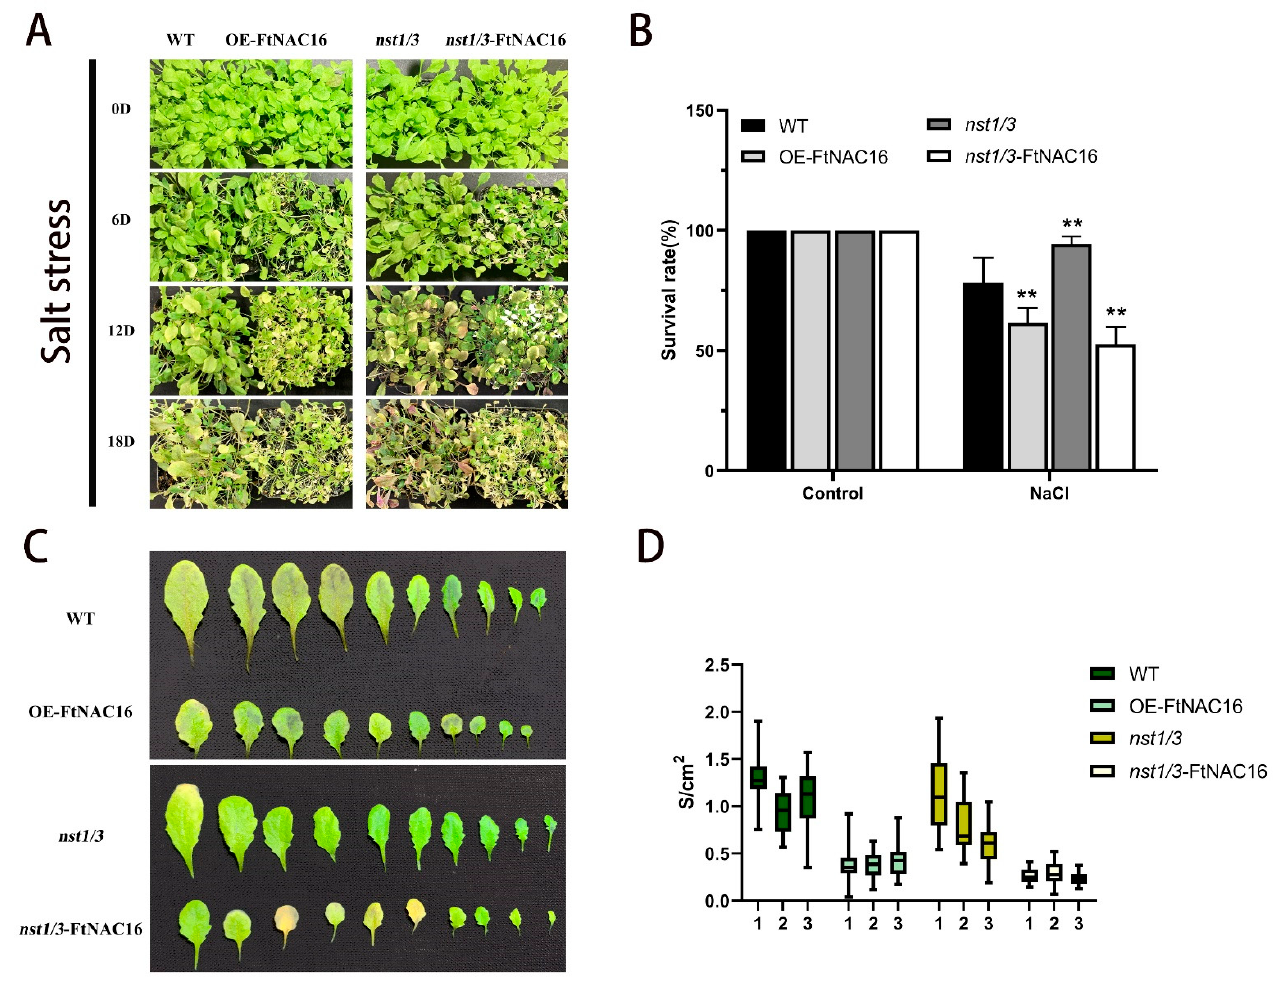
Figure 5. Phenotypic status of the four genotypes after salt stress treatment. ( A ) Growth status of A. thaliana at 0, 6, 12 and 18 days under salt stress; ( B ) After salt stress treatment for 18 days, the survival rates of transgenic plants were counted containing three biological replicates; ** represents t -test significance: p < 0.01.; ( C ) effects of stress on leaf growth of A. thaliana in four genotypes after 18 days; ( D ) by measuring leaf length and width, blade size was calculated based on S = π ab, 25 random repeat samples. The error bars indicate the standard error (SE) of three